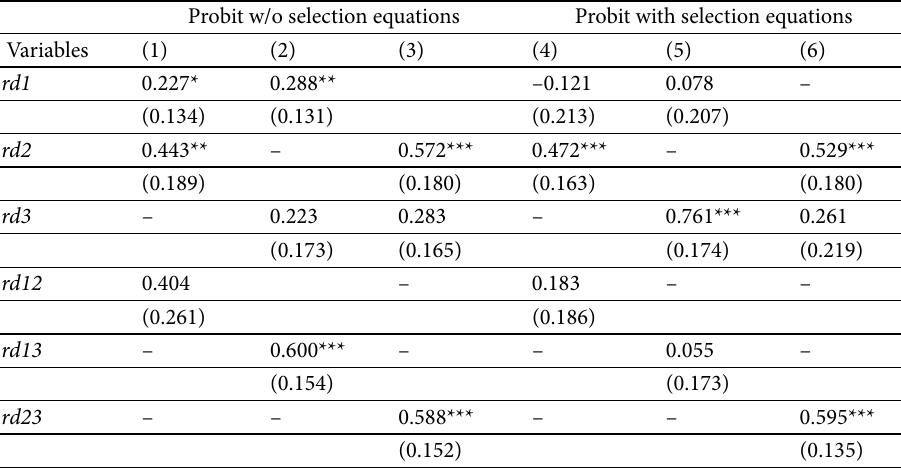
Table A-3. Estimation results of innovation output (measured by whether applying for a patent) Probit w/o selection